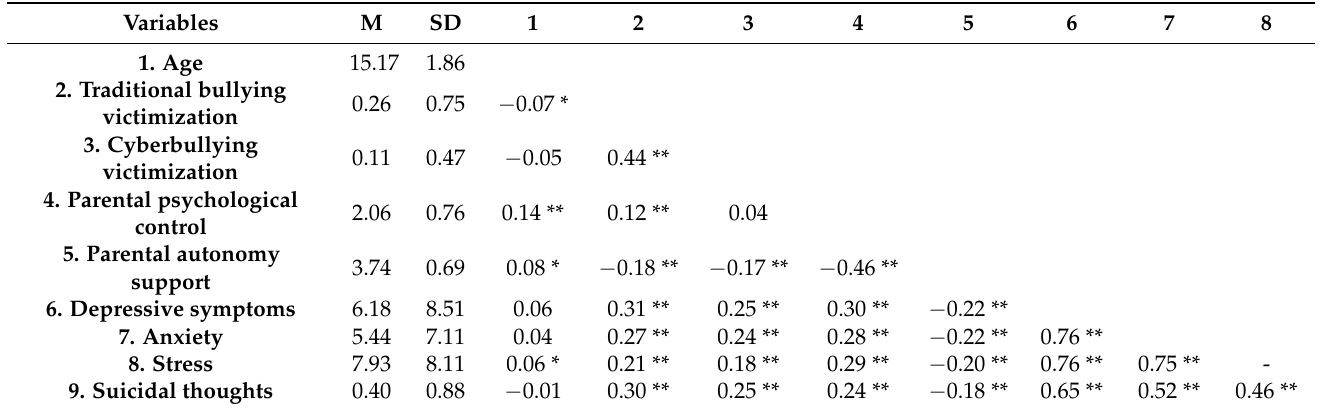
Table 1. Descriptive statistics and correlations of the variables in the study ( n =